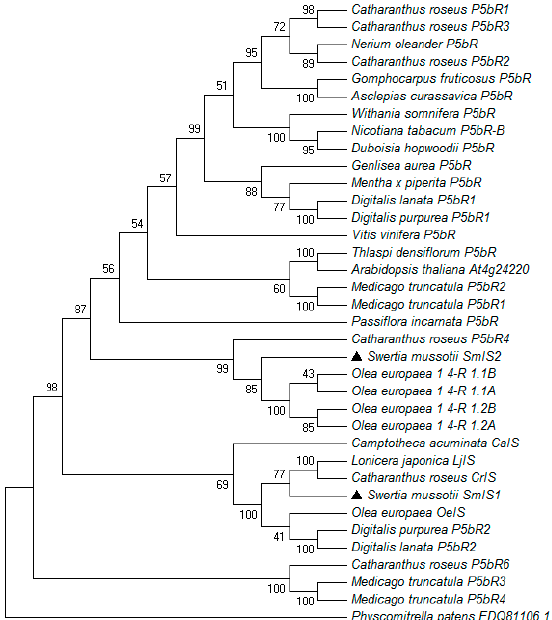
Figure 4. Phylogenetic tree of SmIS1 and SmIS2 together with 34 known P5 β Rs. The phylogenetic tree was drawn using P. patens (GenBank: EDQ81106.1) as an outgroup and the following amino acid